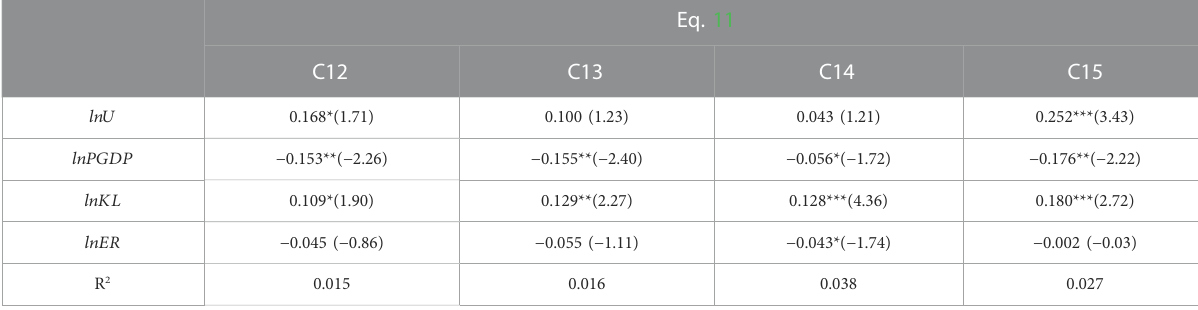
TABLE 6 Robustness regression results of upstream degree and GVC upgrading in subsectors of equipment manufacturing industry.